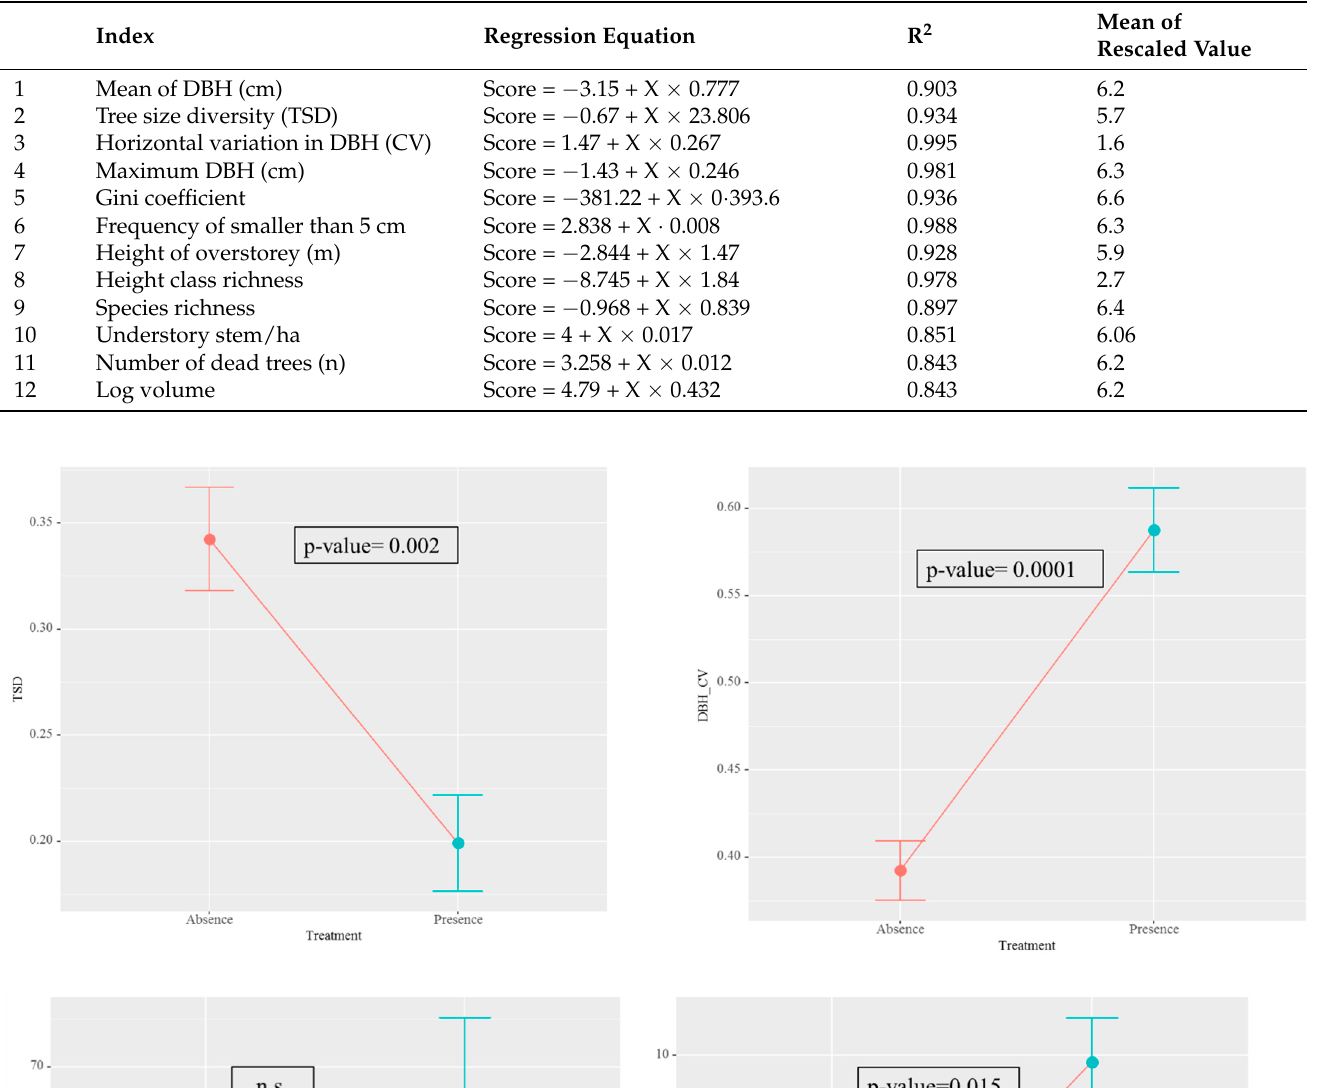
Table 4. Regression equations used to assign a score to the quantitative values of indices on a scale of 0–10.